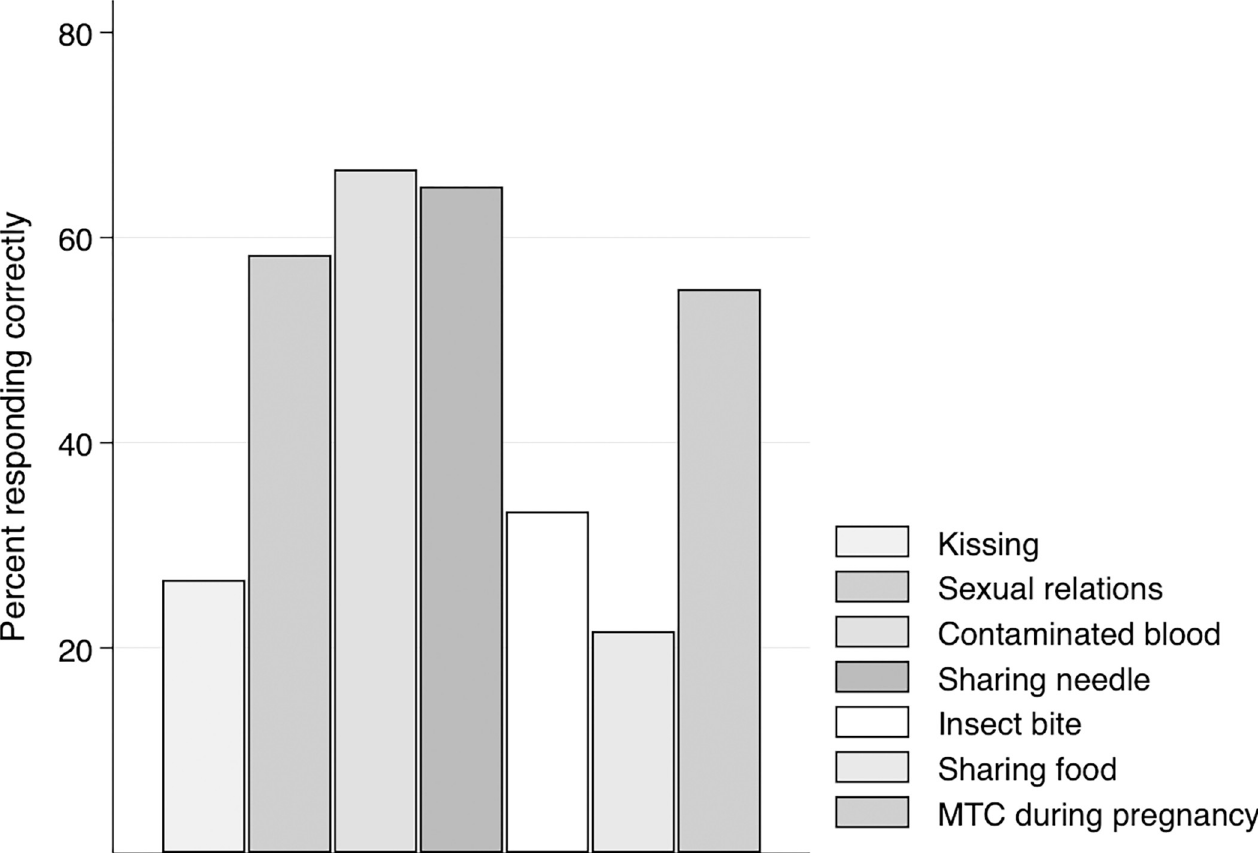
Fig 3. Knowledge of mechanisms of HIV transmission among 15-17-year-old participants who had heard of HIV (N = 60).